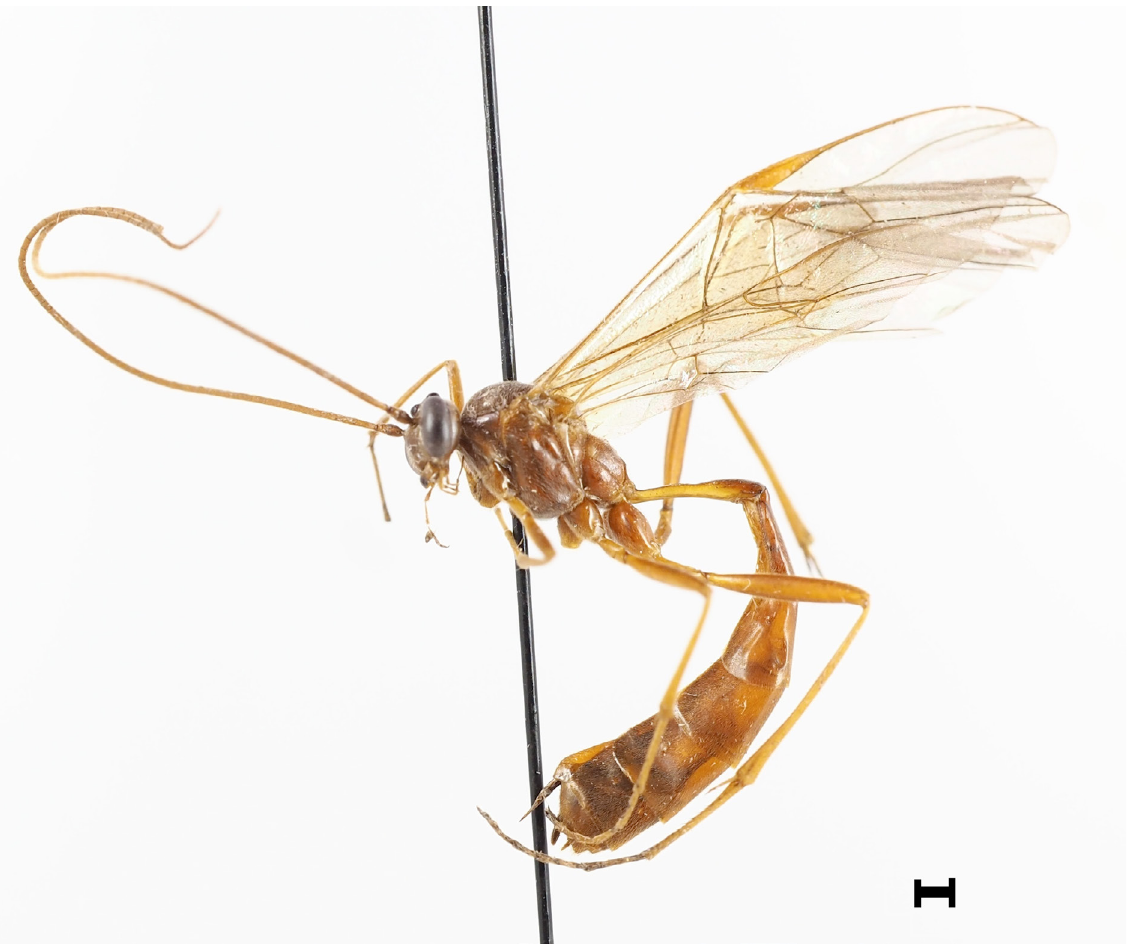
Fig. 33. Ophion inclinans Johansson sp. nov., holotype, ♀ (NHRS-HEVA000008667). Scale bar = 1